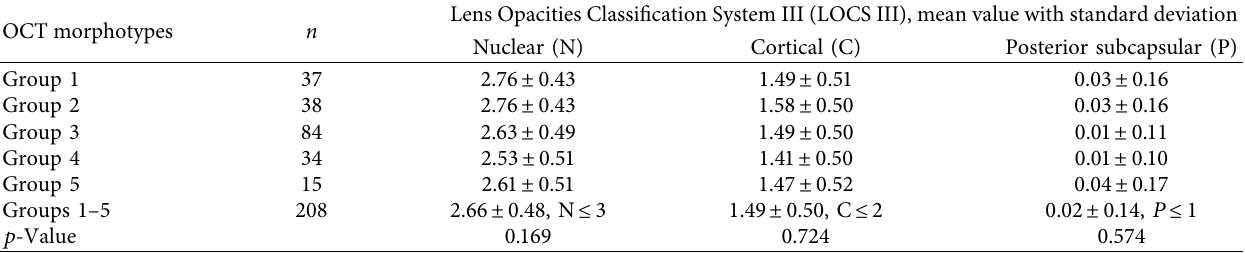
Table 1: The distribution of cataract grading according to lens opacities classification system III (LOCS III) in OCT morphotypes of ERM with designation of the corresponding significance level ( p